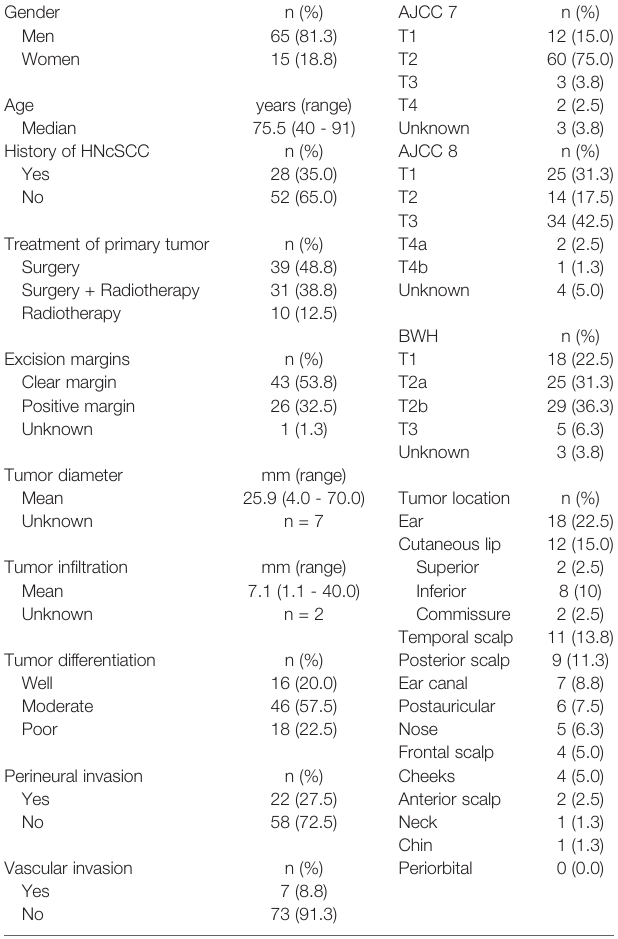
TABLE 1 | Patient and index tumor characteristics. Gender